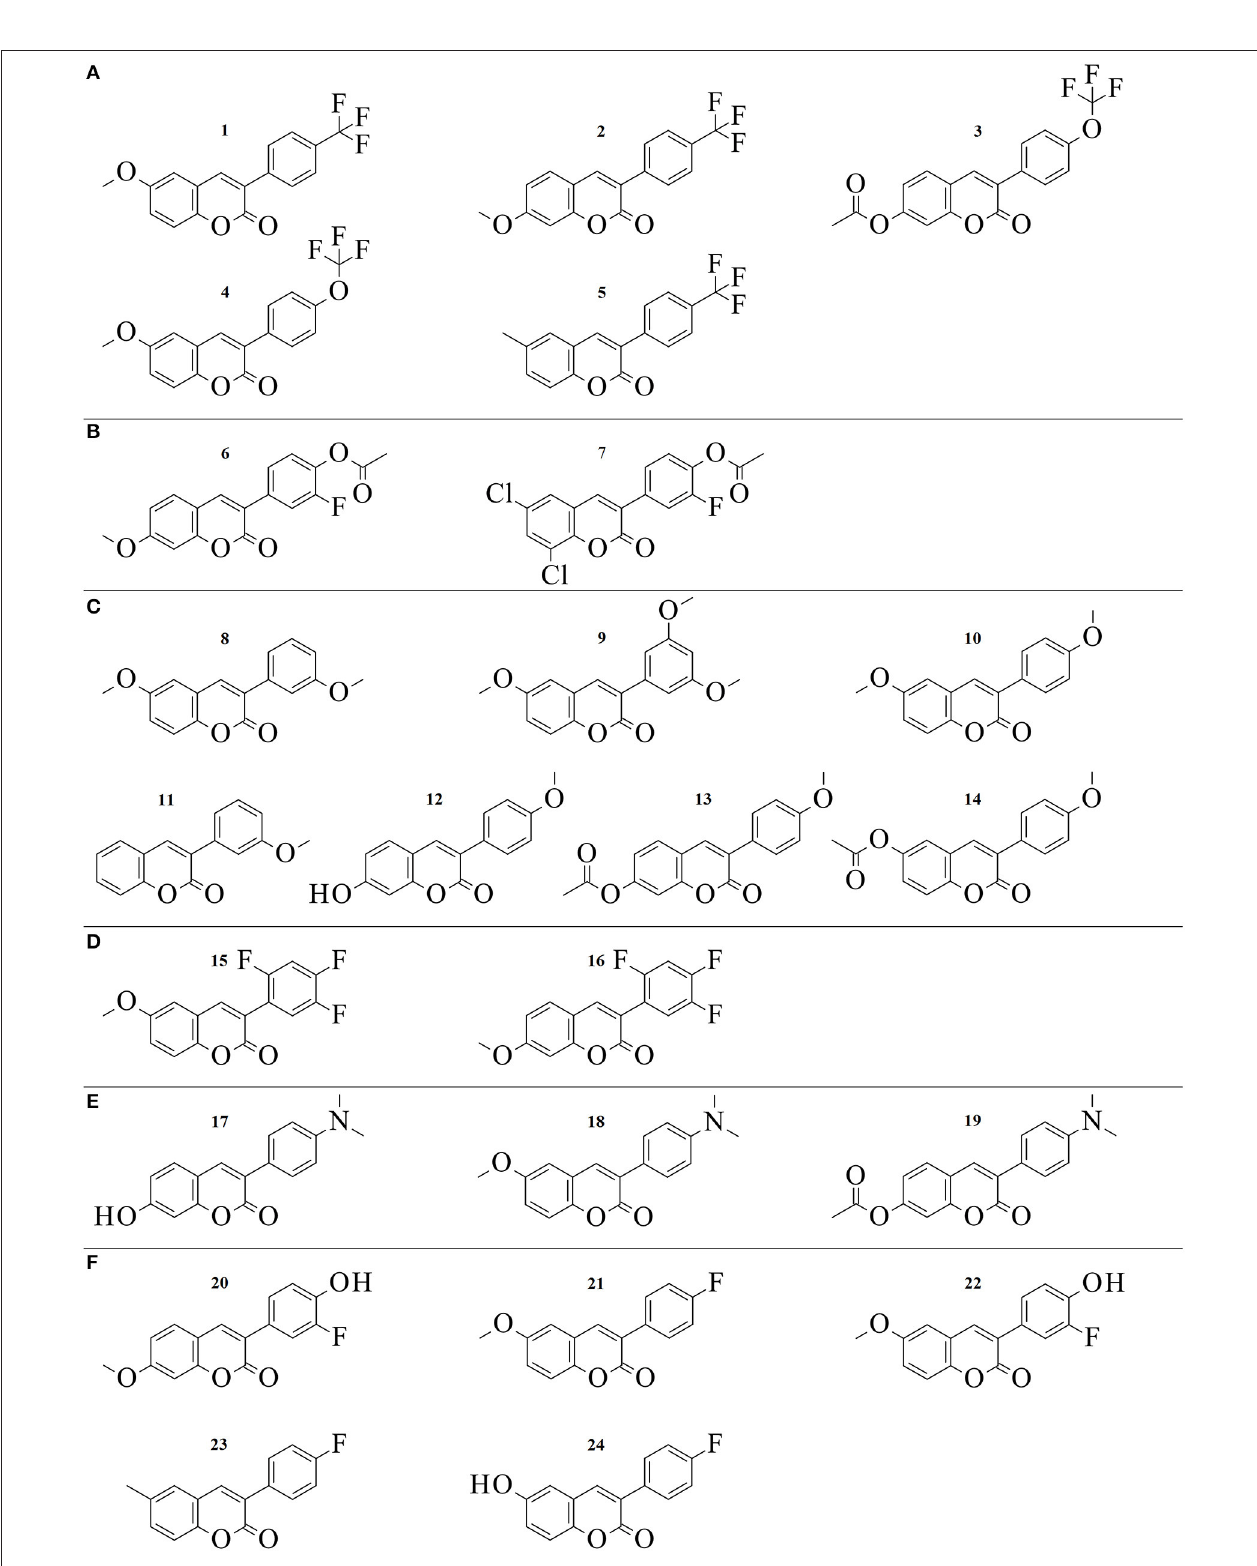
FIGURE 2 | 2D structures of the 24 3-phenylcoumarin derivatives producing at least 70% MAO-B inhibition. The compounds are grouped to (A–F) groups based on the chemical similarity of the R1-R7 substituents ( Figure 1E ). See Table 1 for the detailed activity data.